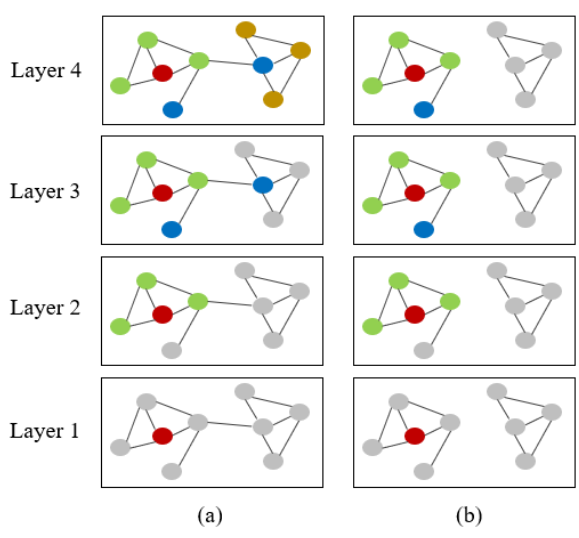
Figure 2 . The neighbourhood expansion contrast of (a) traditional graph convolution and (b) Cluster-GCN model.